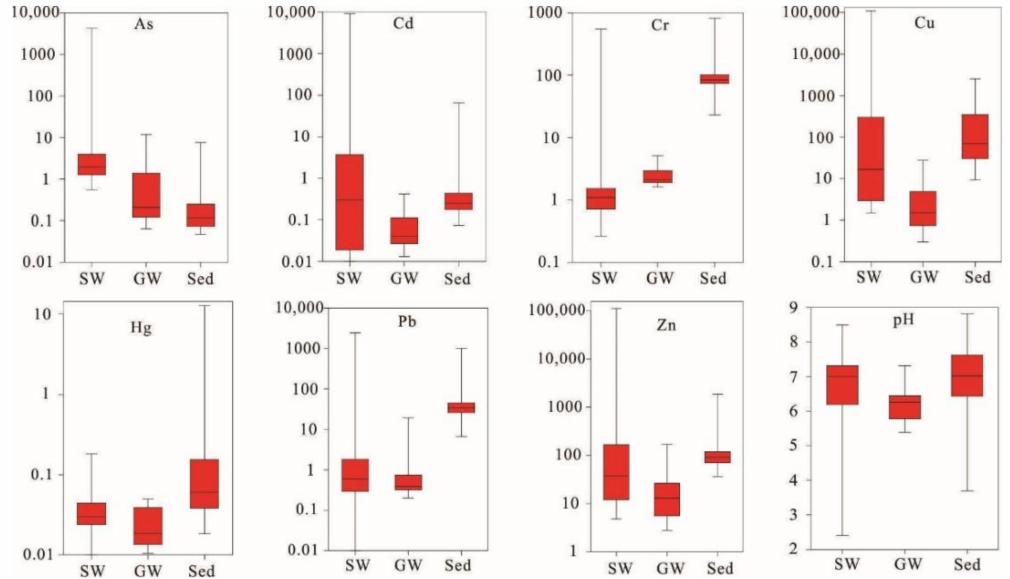
Figure 2. HM concentrations in the surface water (SW, n = 114), ground water (GW, n = 27), and sediment (Sed, n = 200) samples (unit is µ g/L for water and µ g/g for sediment